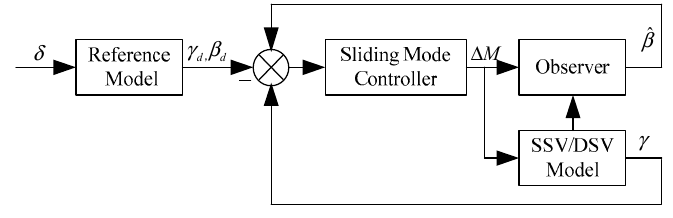
Figure 4. Structure of control system.